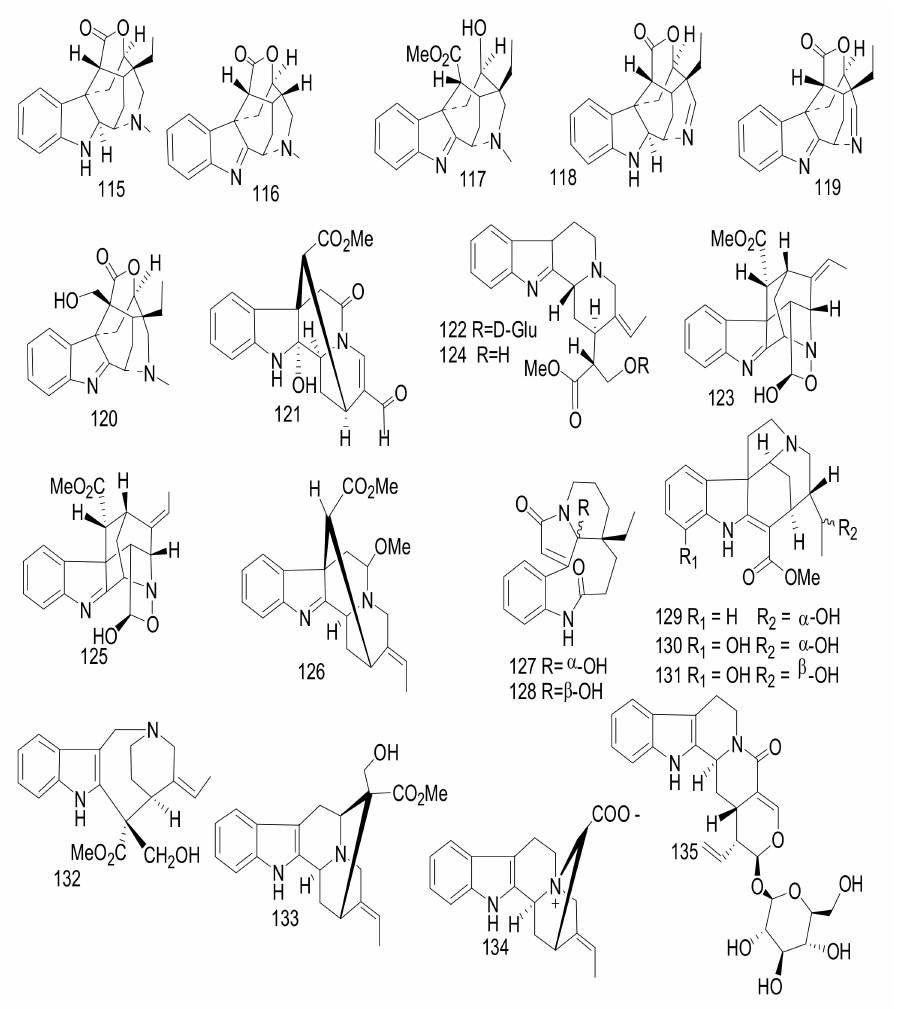
Figure 15. Compounds 115 – 135